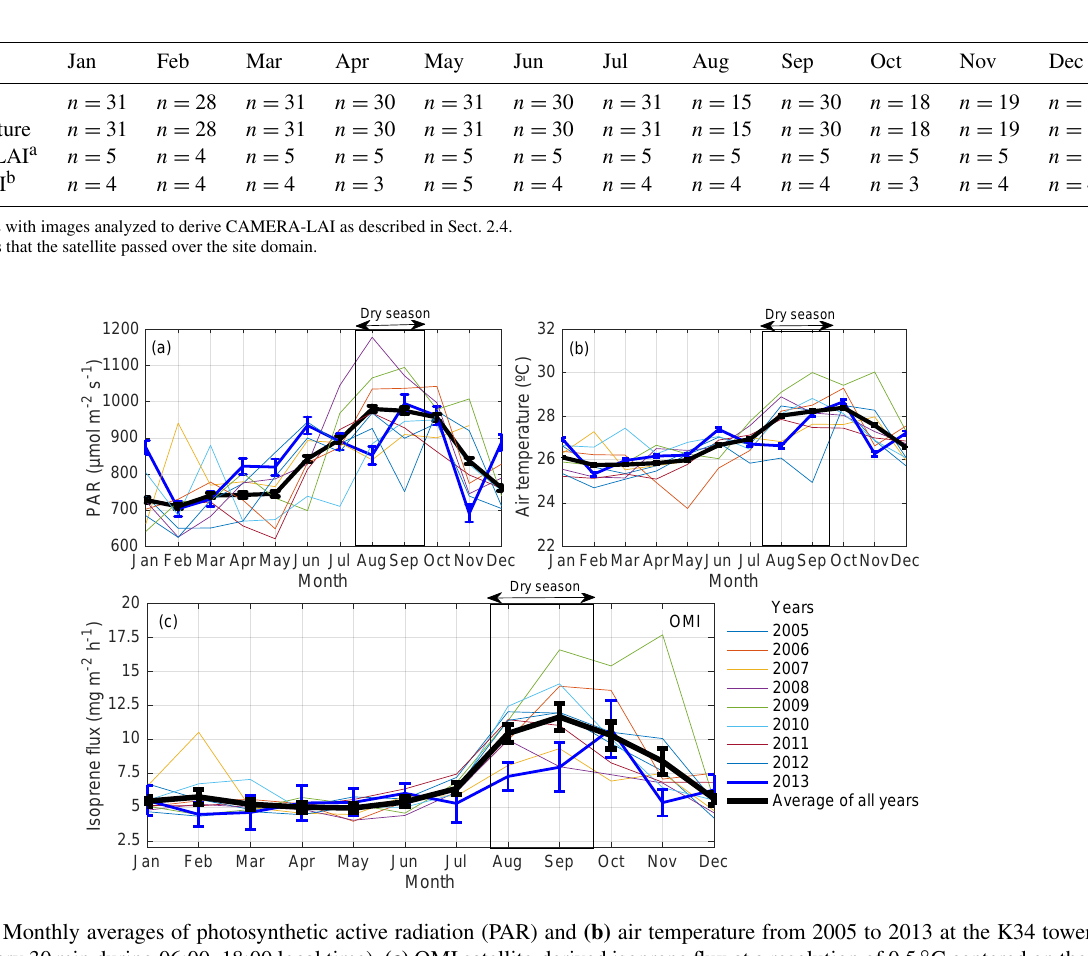
Table 1. Environmental and biological factors used to input MEGAN 2.1: number of days with data available for each variable for the year 2013.